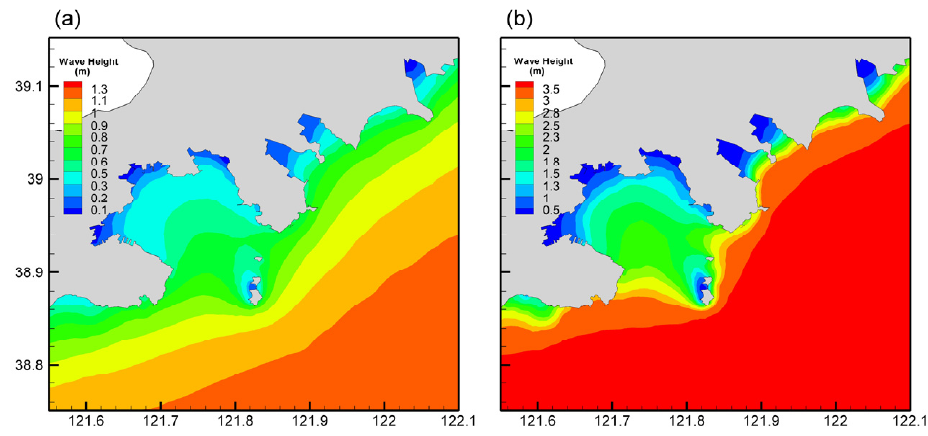
Figure 4. Annual mean significant wave height distribution ( a ) and significant wave heights on 20 September 2021 ( b ).